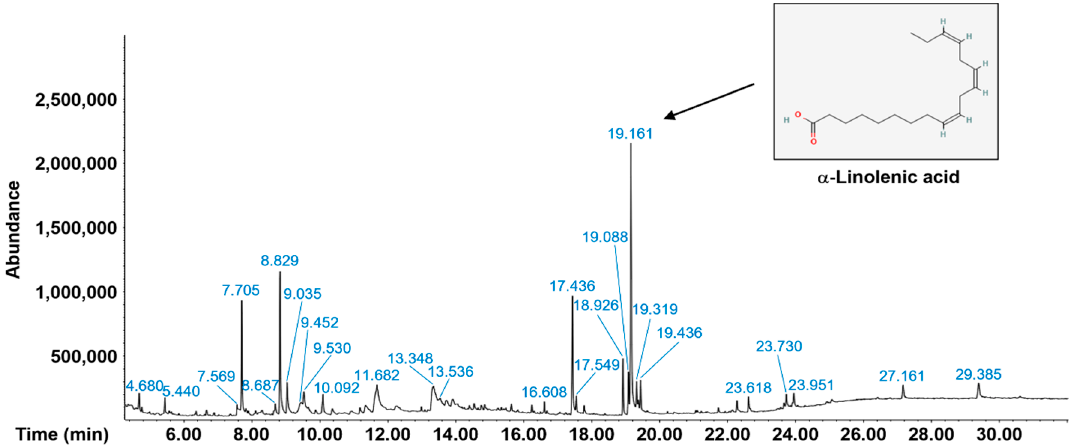
Figure 2. The GC-MS chromatogram of Pp-EE. GC-MS was performed as a phytochemical screen. Table 2. Phytochemical analysis of ethanol extract of Potentilla paradoxa Nutt. by GC-MS. Peak No.